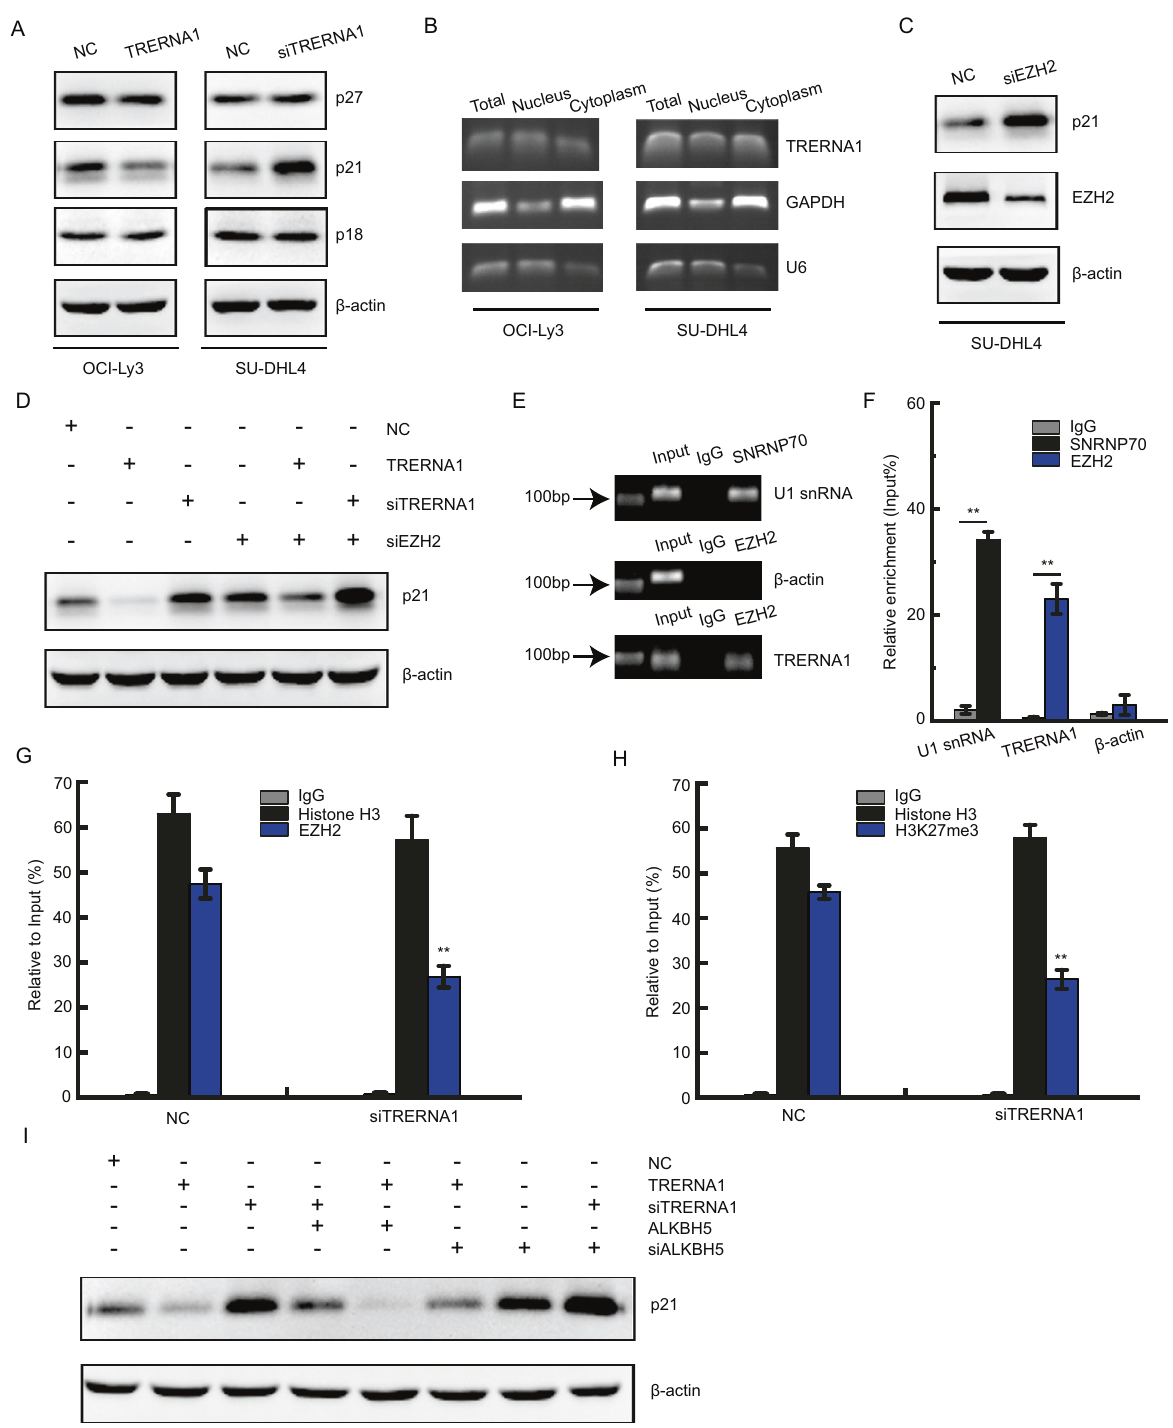
Fig. 5 m 6 A modi fi cation of TRERNA1 epigenetically silences p21 transcription by interacting with EZH2. A The protein levels of cyclin- dependent kinases inhibitors (CDKIs) were detected after TRERNA1 overexpression or downregulation. B The subcellular fractions of TRERNA1 were analyzed by RT-PCR. U6 and GAPDH were used as controls for the nuclear and cytoplasmic fractions, respectively. C The protein levels of p21 were detected after EZH2 downregulation in SU-DHL4 cells. D The protein levels of p21 were detected when knockdown of TRERNA1 and EZH2 collectively. E RIP assays were performed to verify the enrichment of EZH2 on TRERNA1 in SU-DHL4 cells by gel electrophoresis. SNRNP70 and IgG were used as positive and negative controls, respectively. F TRERNA1, U1 snRNA and β -actin from the RIP assay were also analyzed by RT-qPCR. G ChIP assays were performed to evaluate the effects of EZH2 on binding the p21 gene promoter upon TRERNA1 downregulation in SU-DHL4 cells. H ChIP assays were performed to evaluate the effects of H3K27me3 modi fi cation of the p21 gene promoter upon TRERNA1 downregulation in SU-DHL4 cells. Histone H3 and IgG were used as positive and negative controls, respectively. I The expression of p21 was assessed by western blot analysis in cells transfected with ALKBH5 or siALKBH5. The data are presented as the mean ± SD; n = 3. ** P <